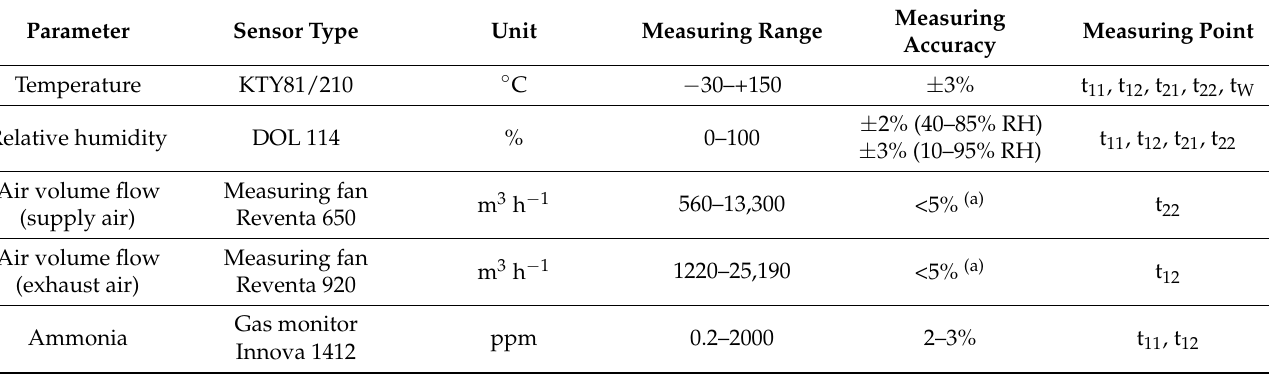
Table A1. Overview of the measurement parameters, sensor types used, measurement ranges, measurement accuracy and the corresponding measurement points. Unless otherwise stated, the measuring ranges and measuring accuracies are according to the manufacturer’s specifications.